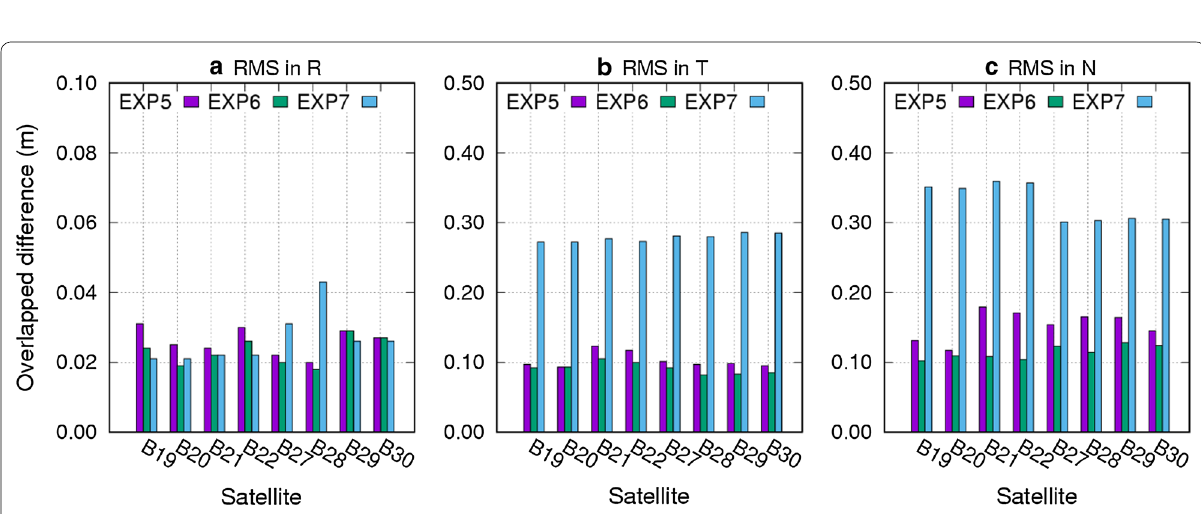
Fig. 7 The accuracies in R, T, and N of the orbits for each satellite obtained in EXP5, EXP6, and